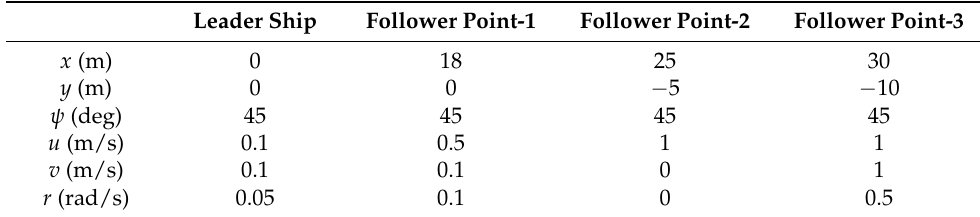
Table 1. Initial states of leader and follower.